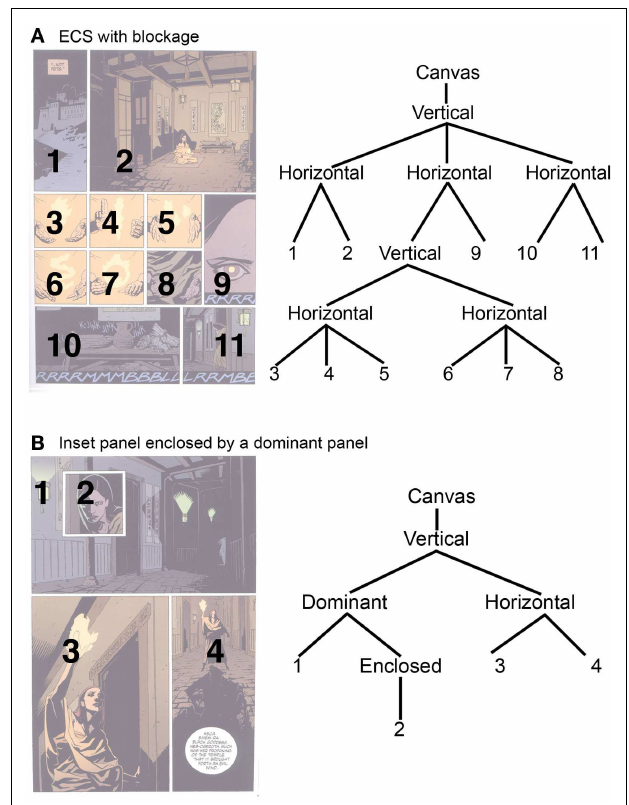
FIGURE 12 | Pages from Mike Mignola’s B.P.R.D . with (A) blockage and (B) an inset panel. © 2003 Mike